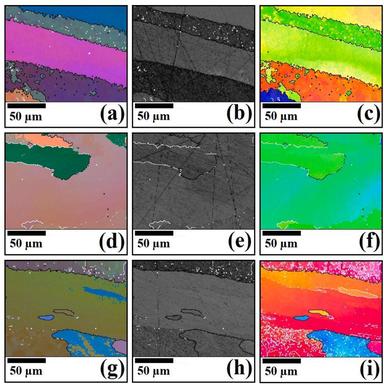
The EBSD grain structural maps for (a-c) X-, (d-f) Y-, and (g-i) Z-sections of printed nanocomposite cube: (a, d, g) Orientation, (b, e, h) boundary, and (c, f, i) inverse pole-figure (IPF) maps.